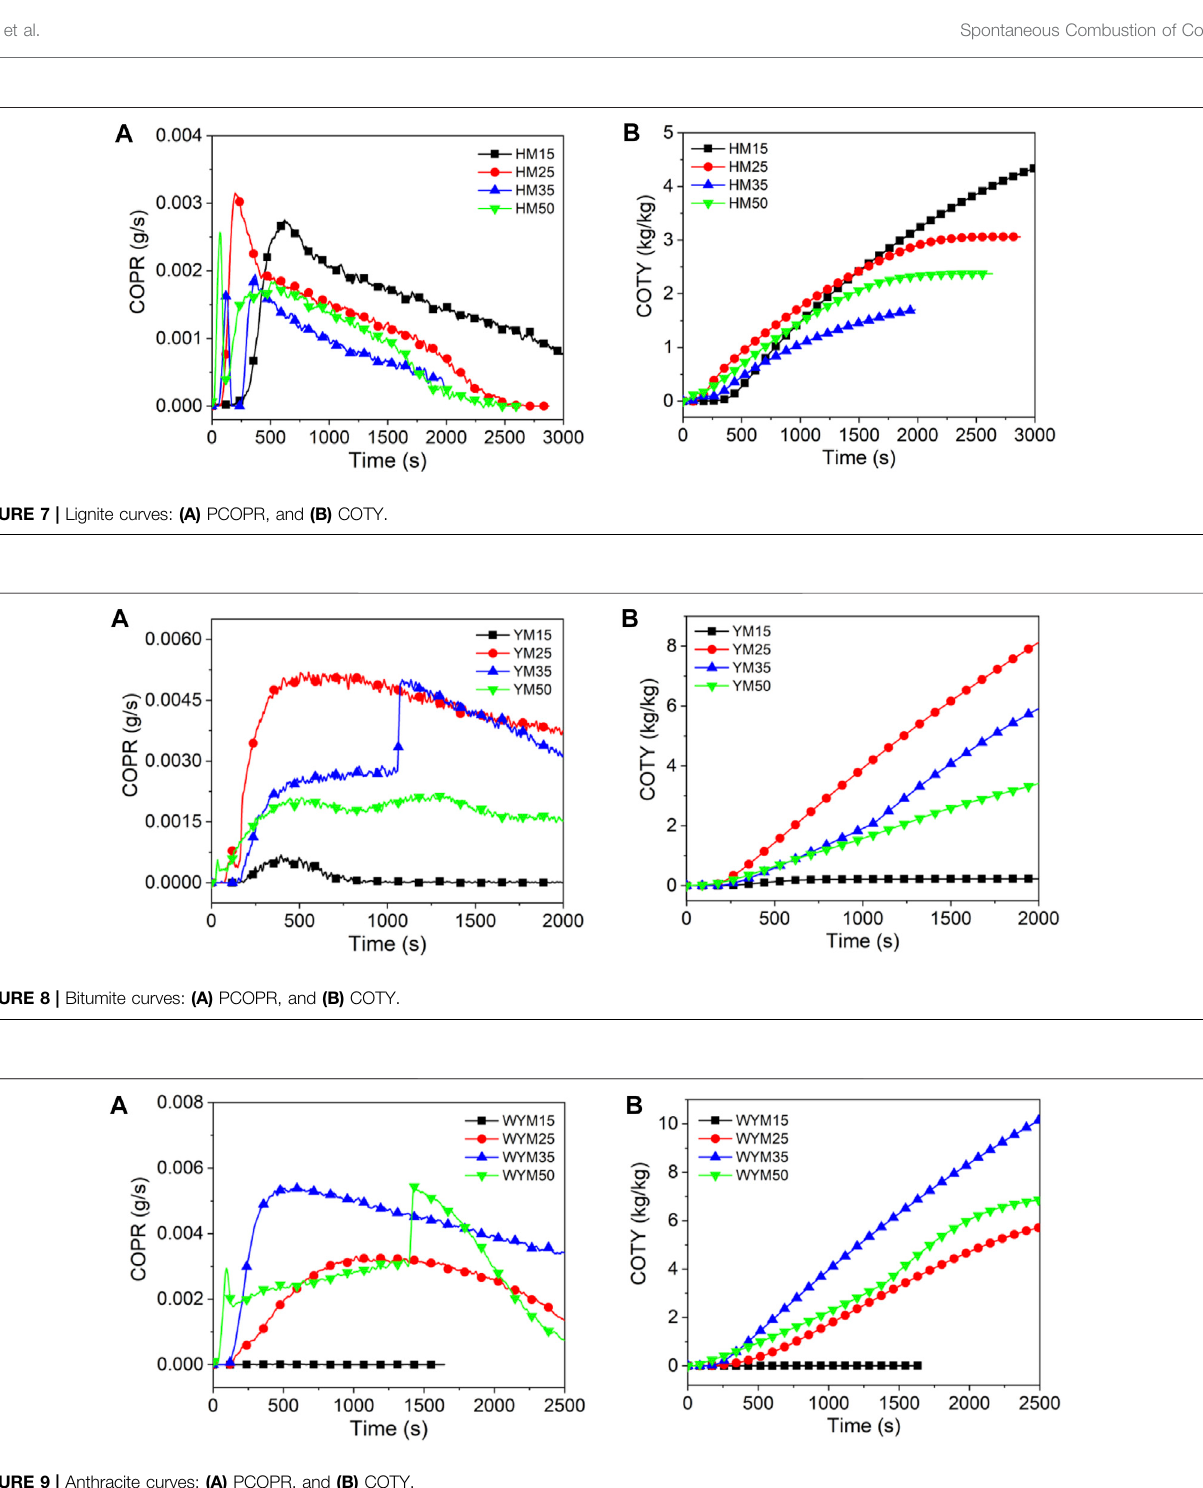
FIGURE 9 | Anthracite curves: (A) PCOPR, and (B)